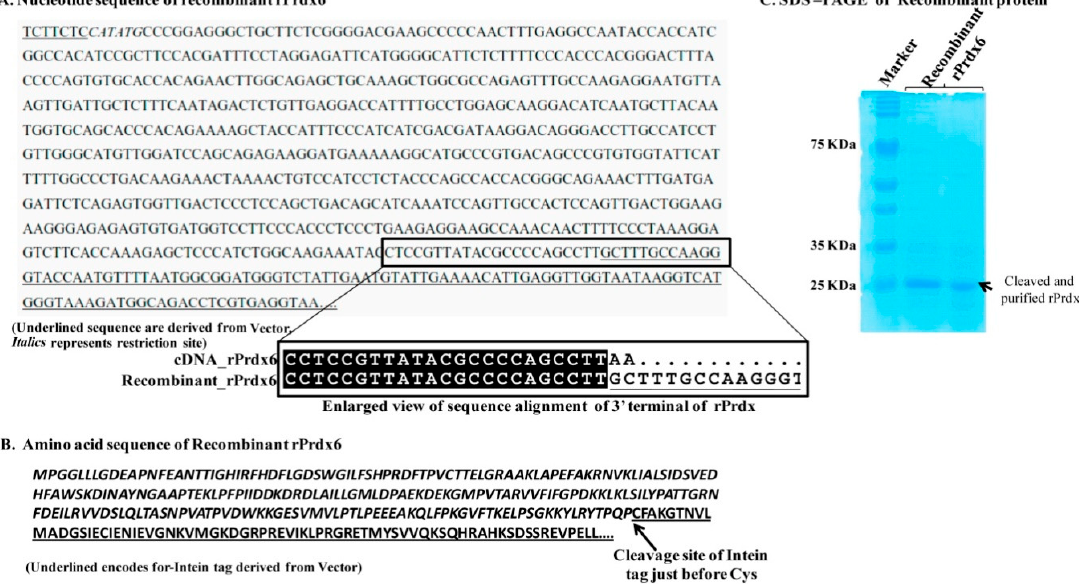
Figure 1. Details of nucleotide sequence of plasmid expressing recombinant rat peroxiredoxin 6 (rPrdx6). The 5 ′ terminal underlined and italics indicate the derived primer that was used. The 3 ′ terminal sequence is vector derived nucleotides after recombinant cloning. Inset view shows the different nucleotides of recombinant plasmid to cDNA sequence of rPrdx6 at 3 ′ terminal ( A ). The amino acid sequence of the prepared construct contains an intein tag for purification. Underlined sequence encodes for the vector derived amino acids. The cleavage site of the protein from purification tag is shown with an arrow ( B ). Sodium dodecyl sulfate polyacrylamide gel electrophoresis (SDS-PAGE) of purified Prdx6 using chitin affinity chromatography. The purity is more than 90% ( C ).